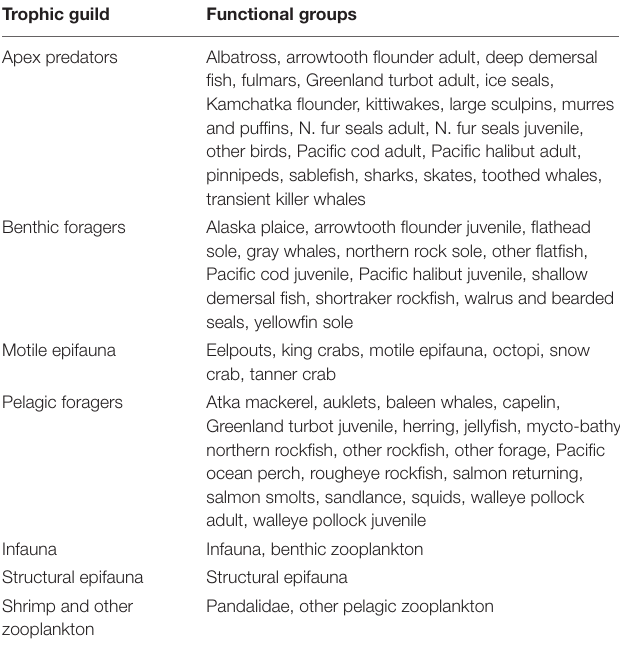
TABLE 2 | The composition of trophic guilds. Trophic guild Functional